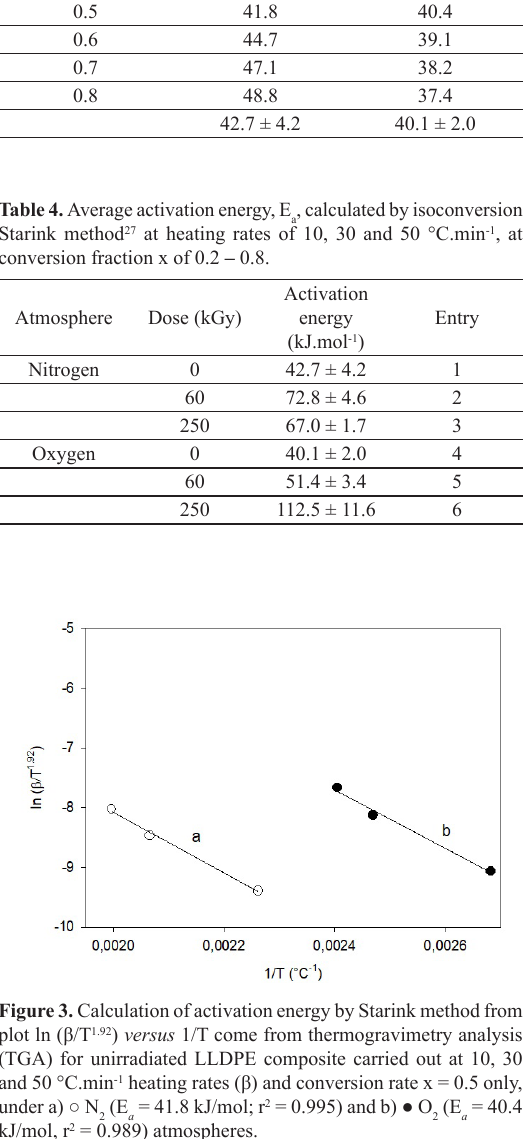
) at conversion fraction x (0.2 – 0.8) a and O atmospheres, by 2 2